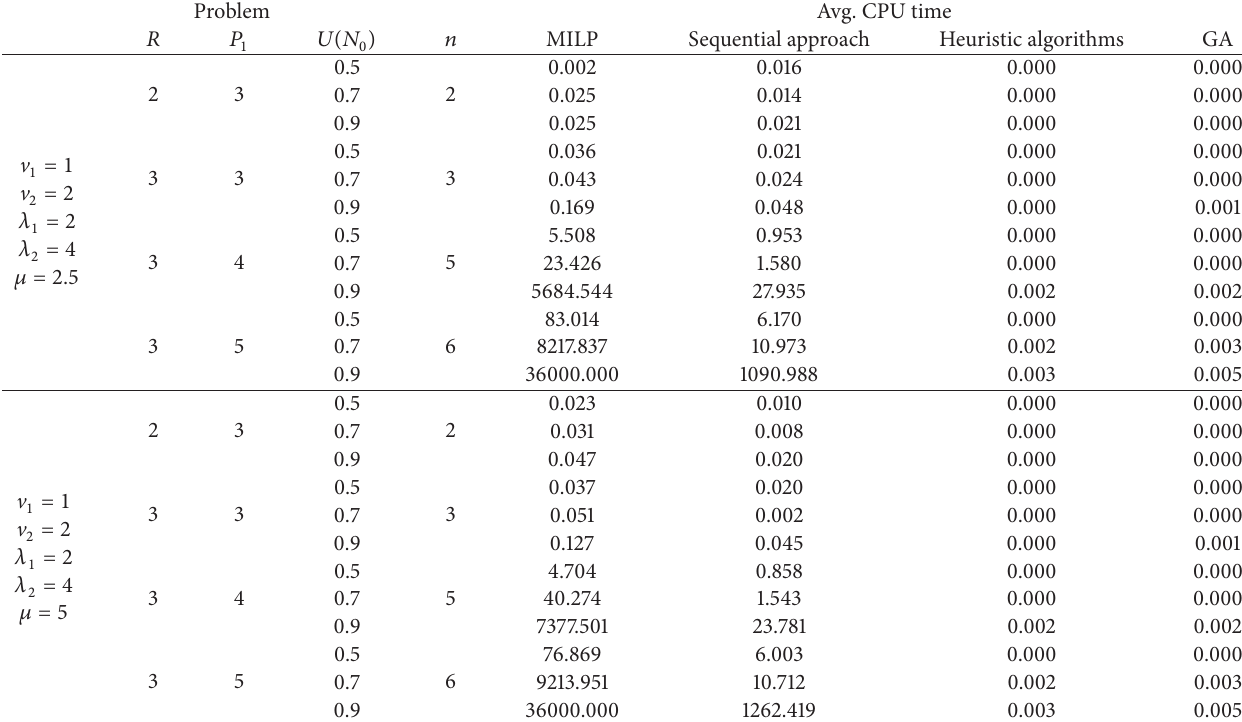
Table 2: The average computational time for smaller scale